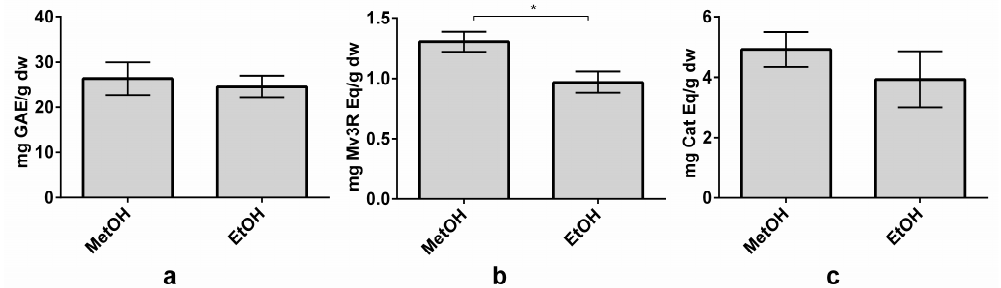
Figure 5. Effect of methanol (MetOH) and ethanol (EtOH) on total phenolic content (TPC) ( a ), total anthocyanin content (TAC) ( b ), and total flavanol content (TFC) ( b ) on organic whole red Grenache grapes. Results are expressed as mg of phenolic equivalents per gram of dry weight (mg Eq/g dw) ± SD (n = 3). * p < 0.05. Abbreviations: gallic acid equivalents (GAE), malvidin-3- O -rutinoside (Mv3R) and catechin (Cat).